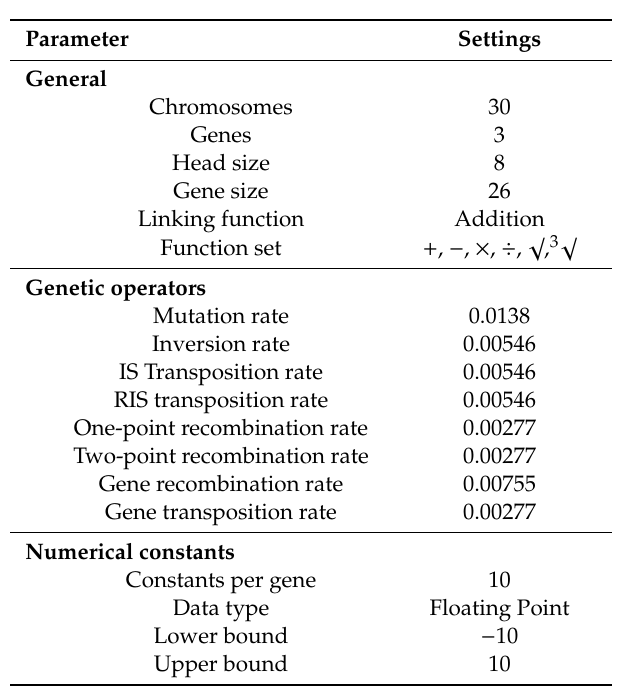
Table 3. GEP parameters